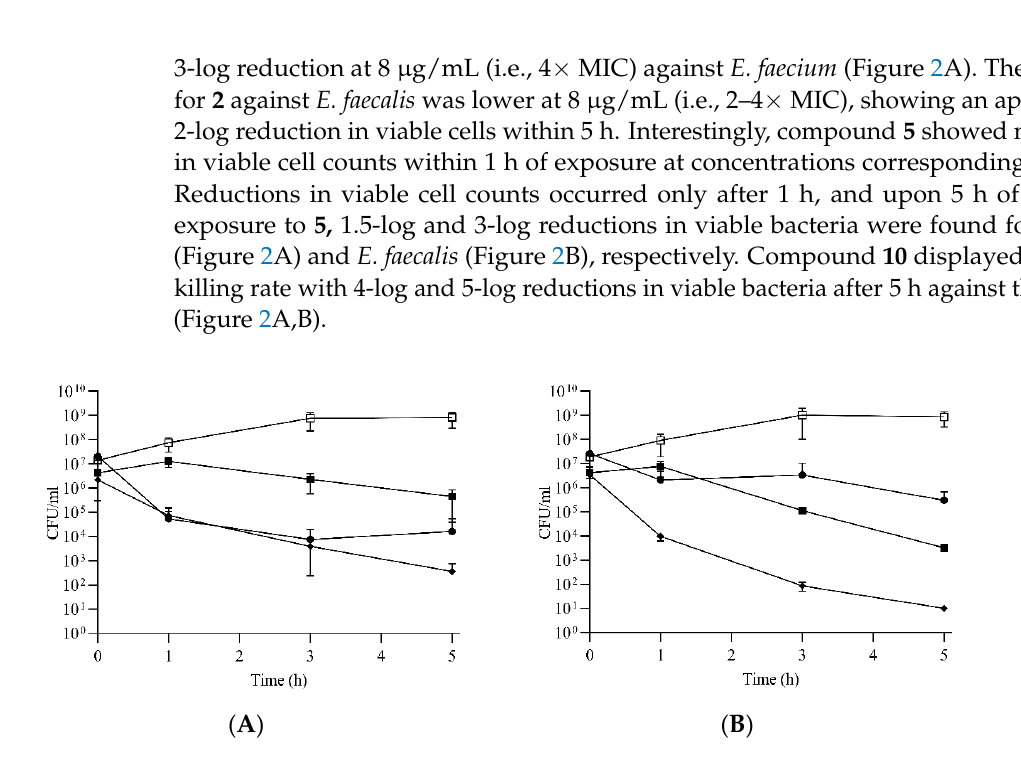
Figure 2. Compounds 2 , 5 and 10 kill enterococci. Time–kill curves for E. faecium ATCC19434 ( A ) and E. faecalis ATCC29212 ( B ) treated with compound 2 ( • ), 5 ( (cid:4) ) and 10 ( (cid:7) ) at concentrations corresponding to 4 × MIC. Growth controls in untreated BHI broth for both strains are also displayed ( (cid:3) ). Each time point represents the average of at least three biological replicates and the error bars represent the standard deviation.